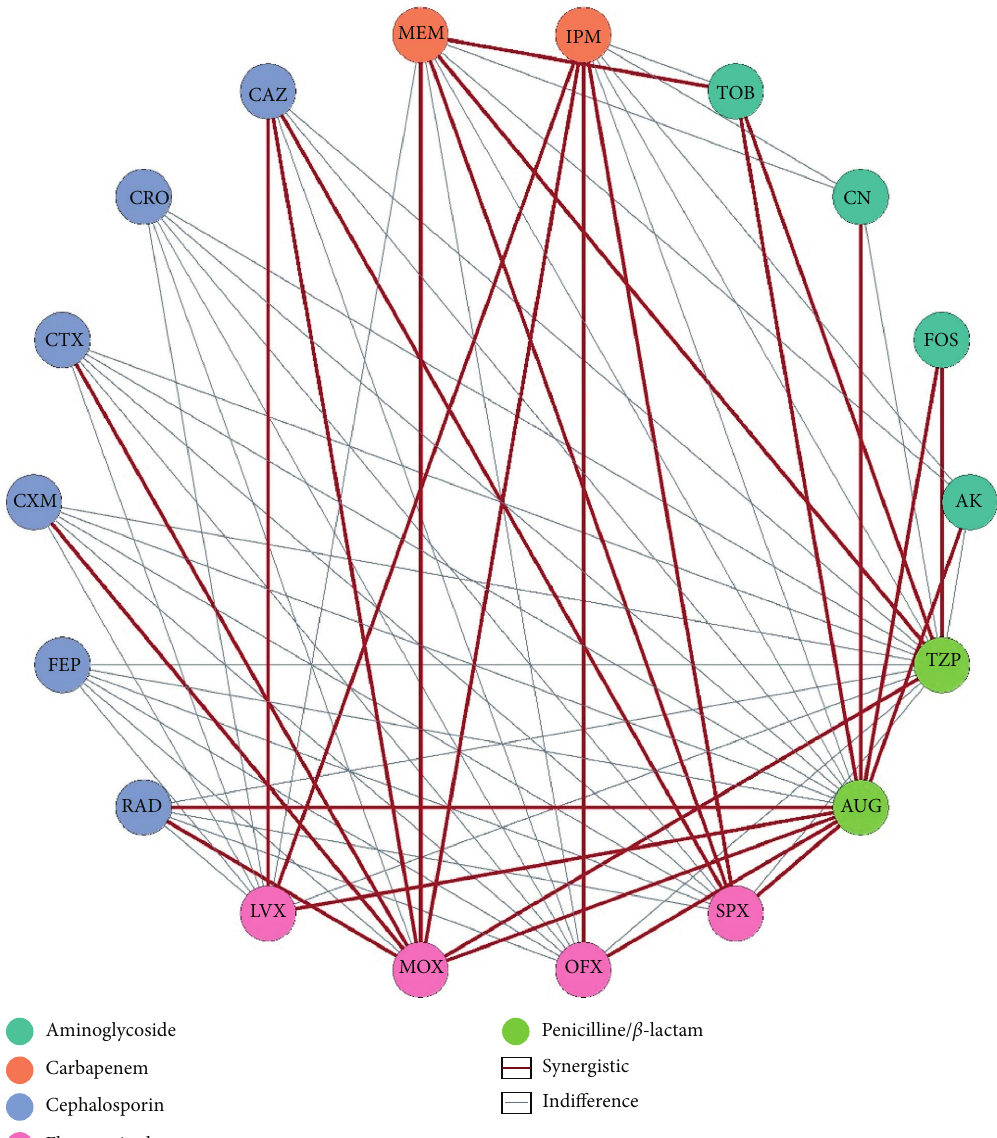
Figure 1: Pairwise antibiotic testing against MRSA. (a) List of pairwise combinations. (b) MIC by broth microdilution indicates that synergistic relationship exists between moxifloxacin and lower-generation cephalosporin (FICI 0.14–0.265). (c) Levofloxacin-ceftazidime shows FICI value as low as 0.281 indicating synergy. (d) Meropenem demonstrates synergy with higher generation of fluoroquinolones, i.e., moxifloxacin (FICI 0.132) and sparfloxacin (FICI 0.265). (e) Imipenem shows collateral sensitivity with all fluoroquinolones (FICI 0.126